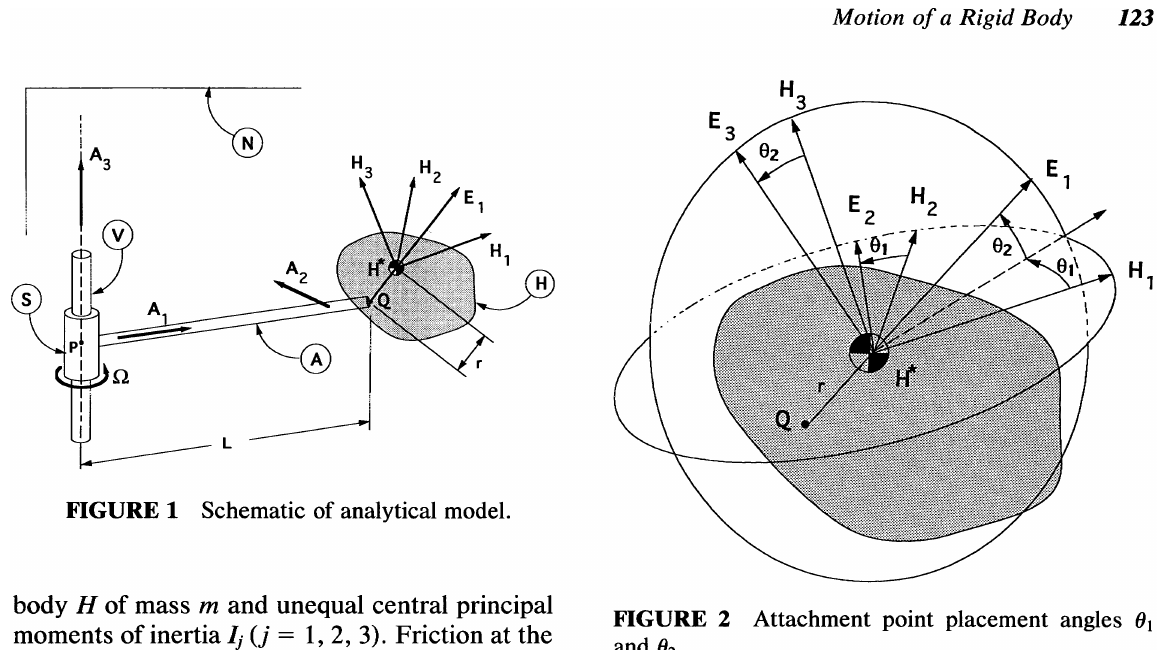
FIGURE 2 Attachment point placement angles 8 1